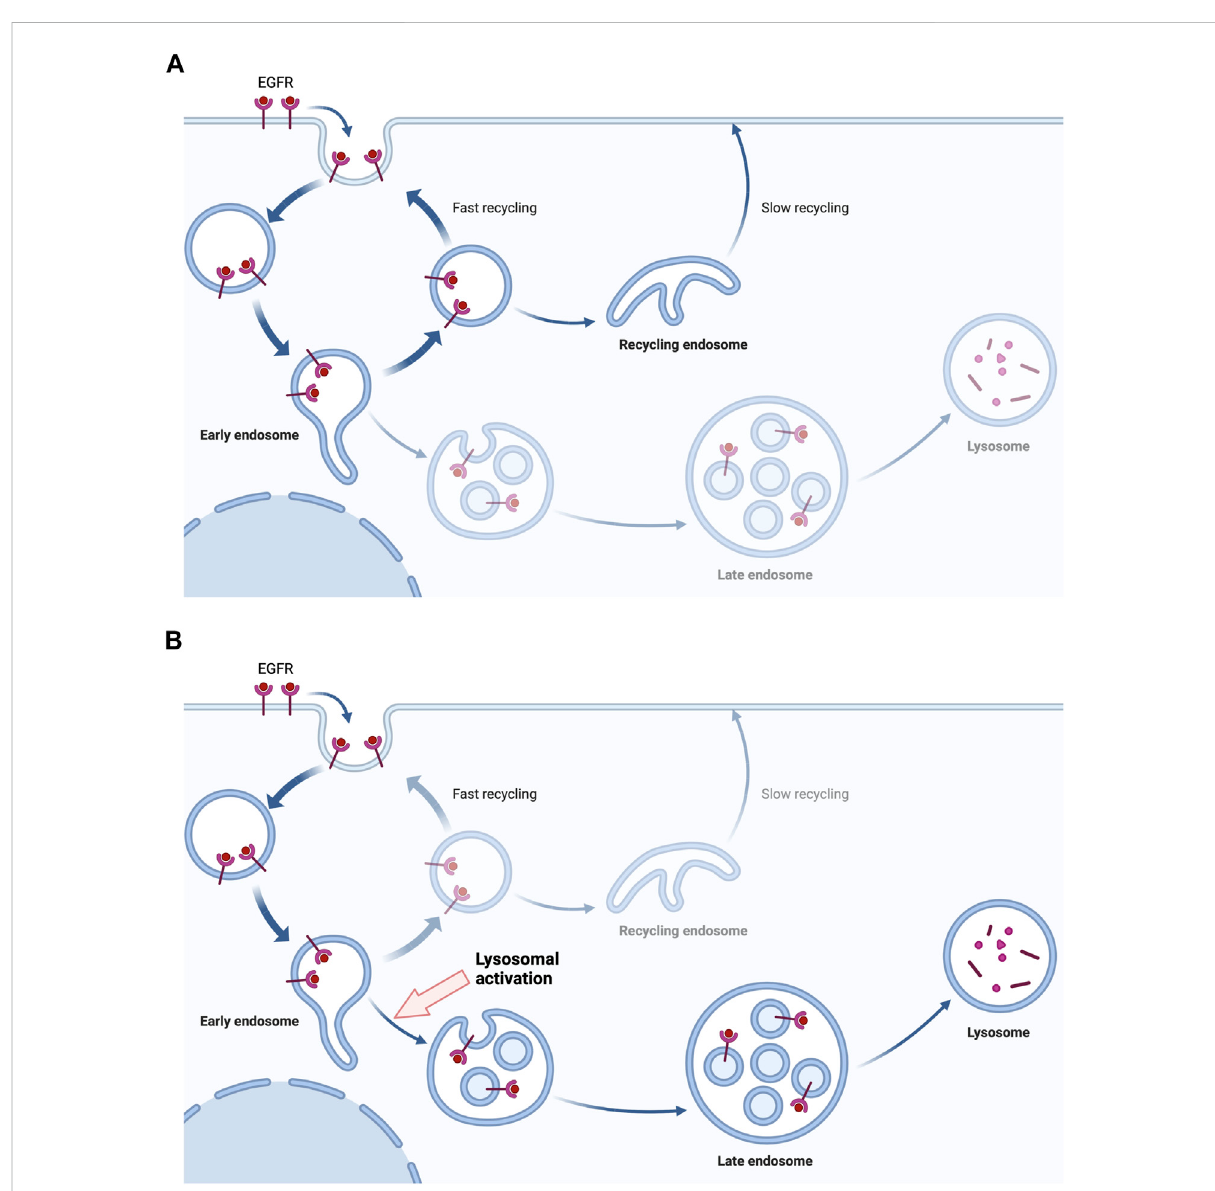
The lysosome activation drives the degradation of EGFR. The binding of EGF initiates the endocytosis of EGFR, inducing downstream signals. The endocytosed EGFR in endosomes is being recycled in tumor cells with EGFR mutation or overexpression (A) . However, the activation of lysosomes gives the drive force to the lysosomal degradation of endocytosed EGFR rather than the recycling (B) . Created with